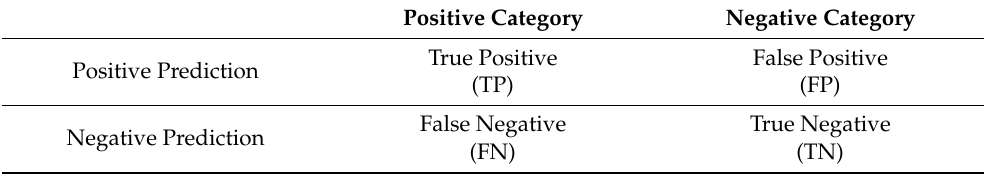
Table 2. Relationship between forecast